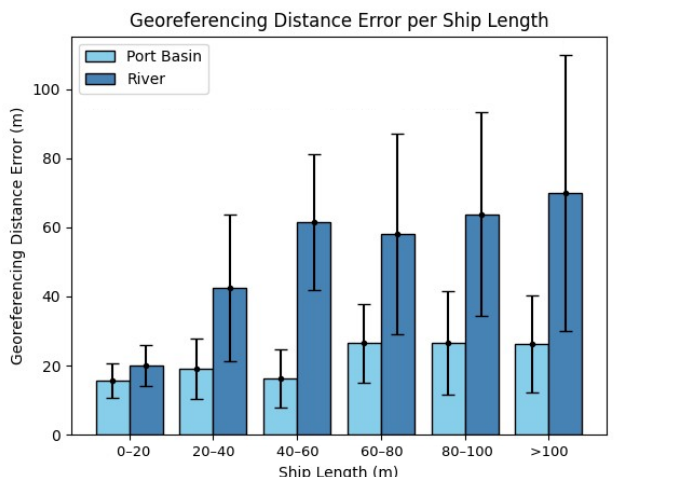
Figure 8. Georeferencing distance error per ship length. GDEs and their uncertainties fall within the bounds of the ship